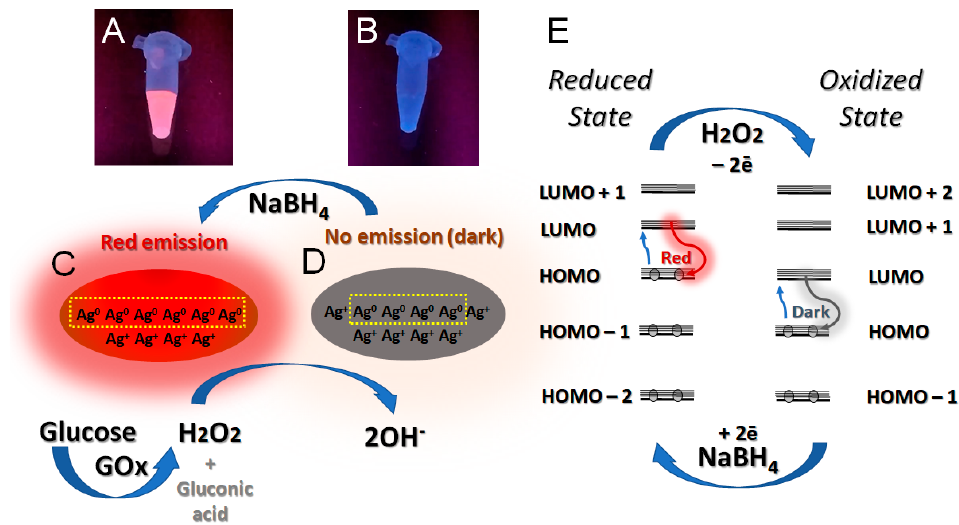
Figure 1. ( A ) Fluorescence of AgNC@hpC 12 sample excited by UV on a transilluminator, ( B ) fluorescence of AgNC@hpC 12 sample excited by UV on a transilluminator after addition of excess H 2 O 2 , ( C ) schematic representation of the nanocluster’s structure and composition before oxidation, ( D ) schematic representation of the nanocluster’s structure and composition after oxidation, ( E ) schematic representation of the effect of oxidation–reduction on the redistribution of electrons showing new possibility for excitation and emission of “dark” AgNCs.